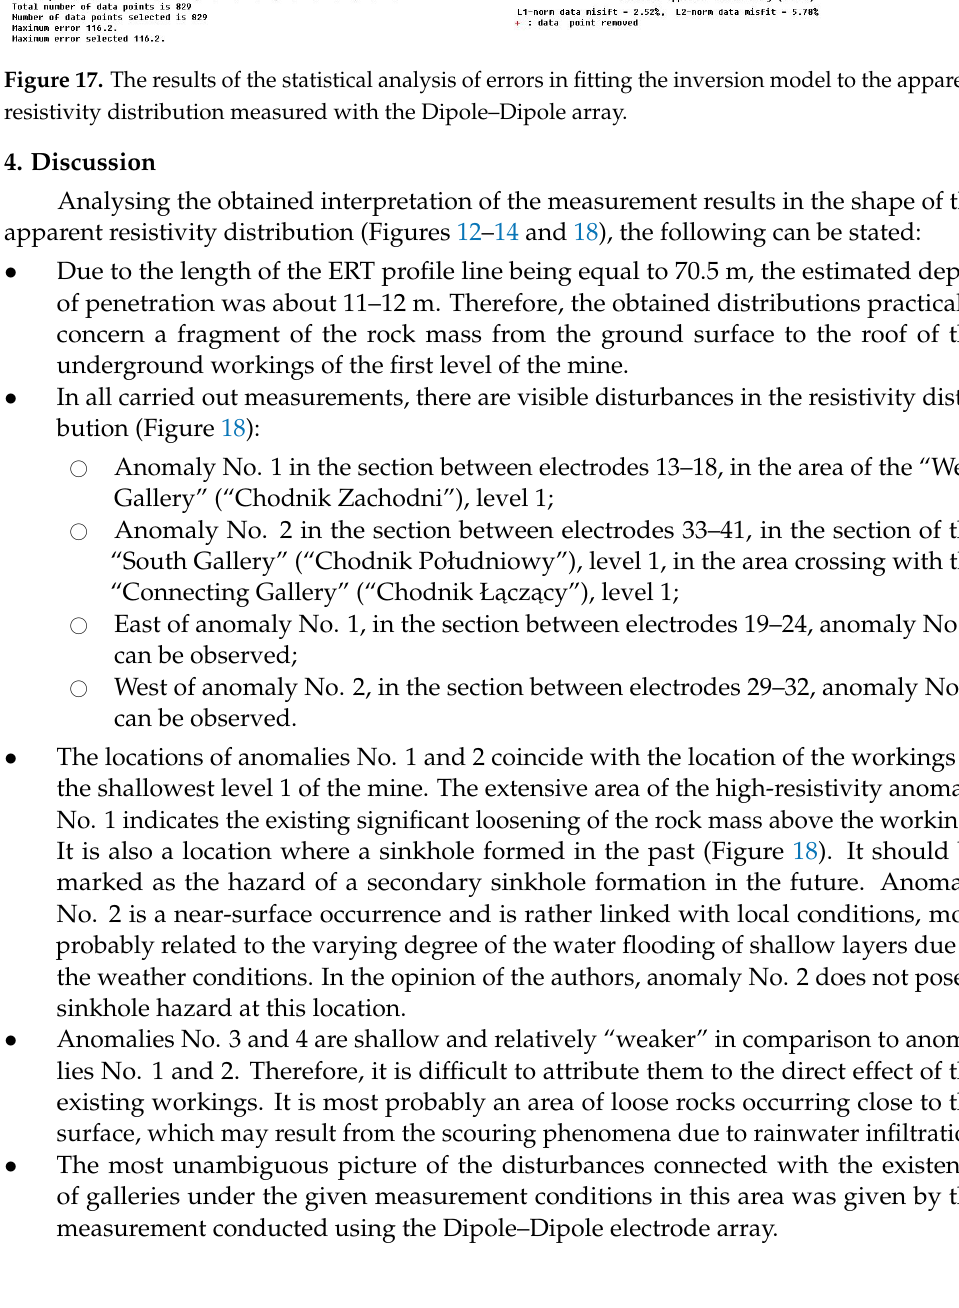
Figure 17. The results of the statistical analysis of errors in fitting the inversion model to the apparent